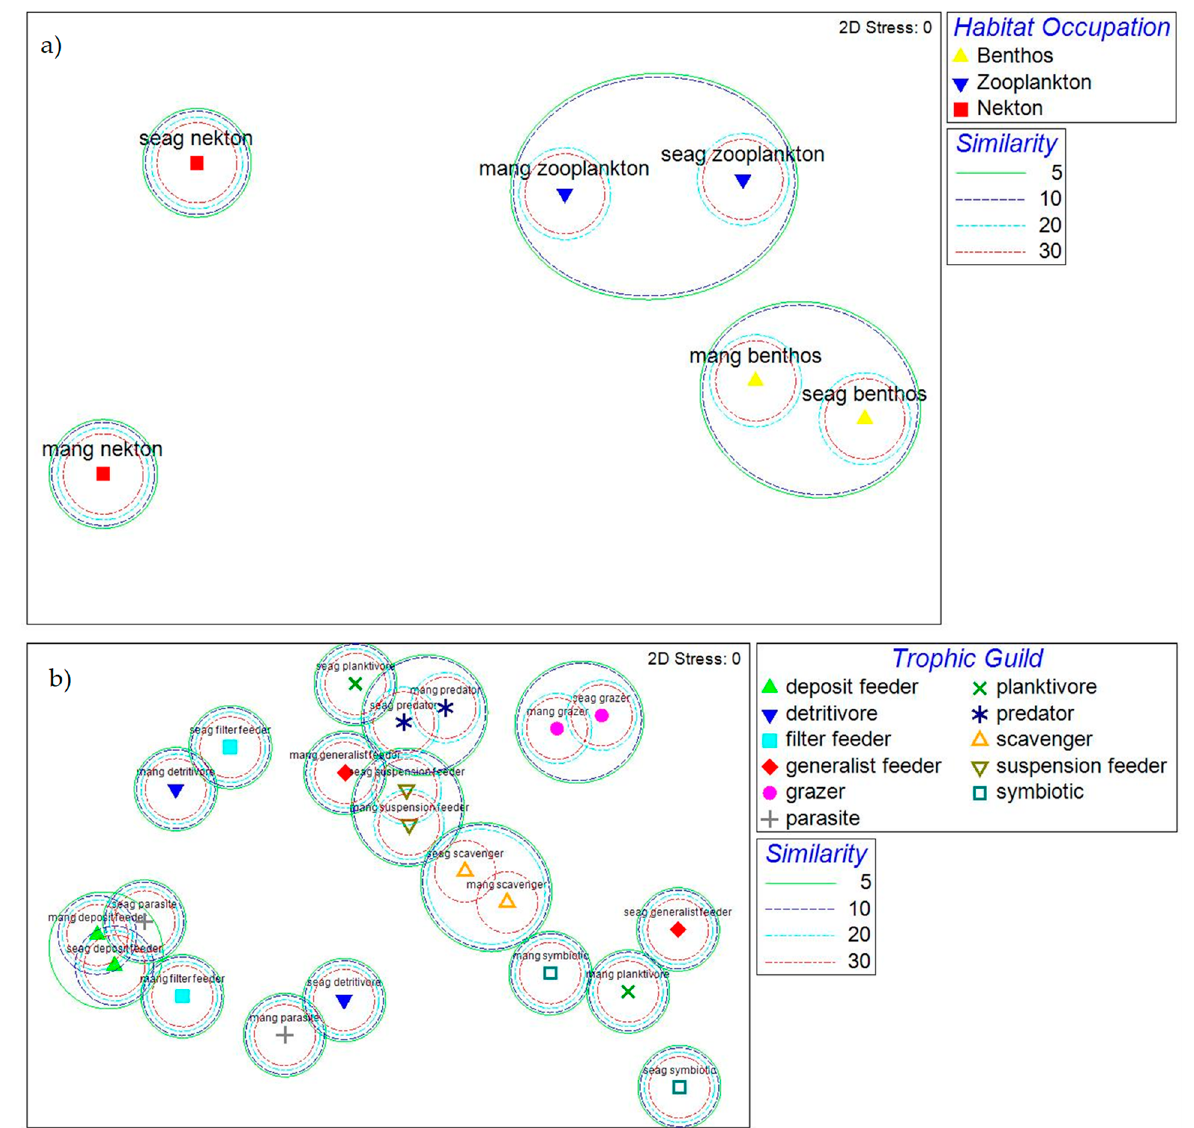
Figure 7. MDS configuration of marine macroinvertebrate community composition related to ( a ) habitat occupation and ( b ) trophic guild in Maputo Bay´s mangroves and seagrasses, with superimposed clustering based on Bray–Curtis similarities (similarity in percentage).